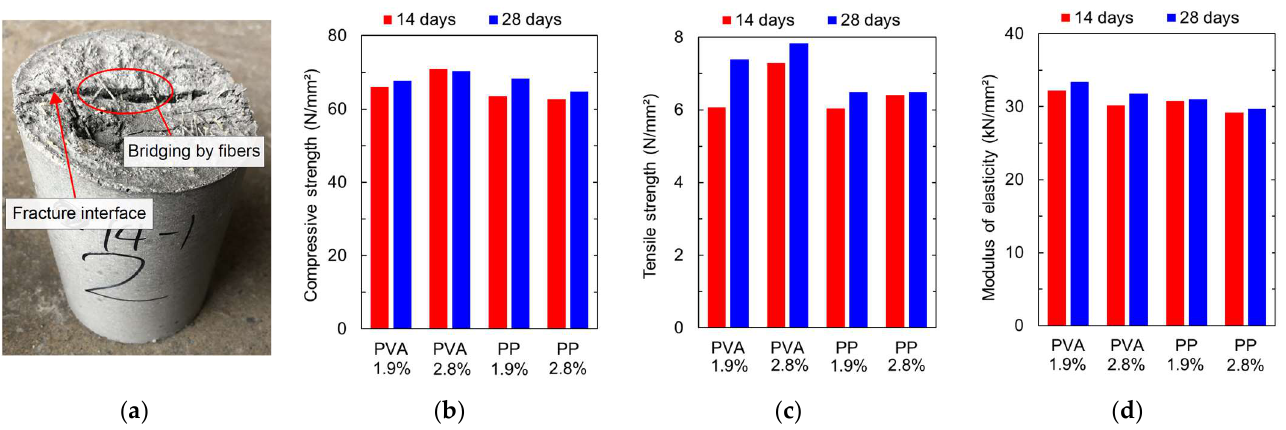
Figure 4. Material test results: ( a ) test piece after split test and material test results of fiber-reinforced mortar: ( b ) compressive strength; ( c ) split tensile strength; ( d ) modulus of elasticity.